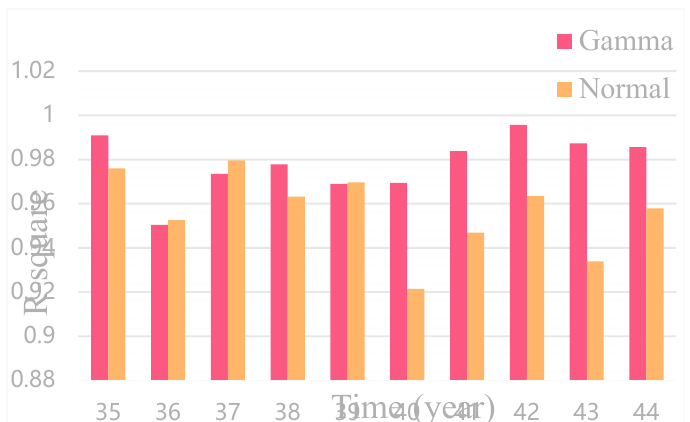
Figure 4. Distribution fitting of compressive strength.